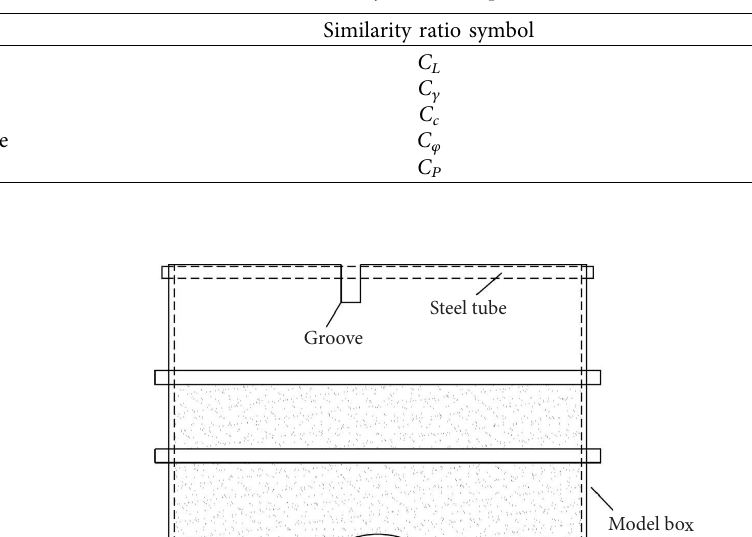
Table 2: Key similitude parameter.